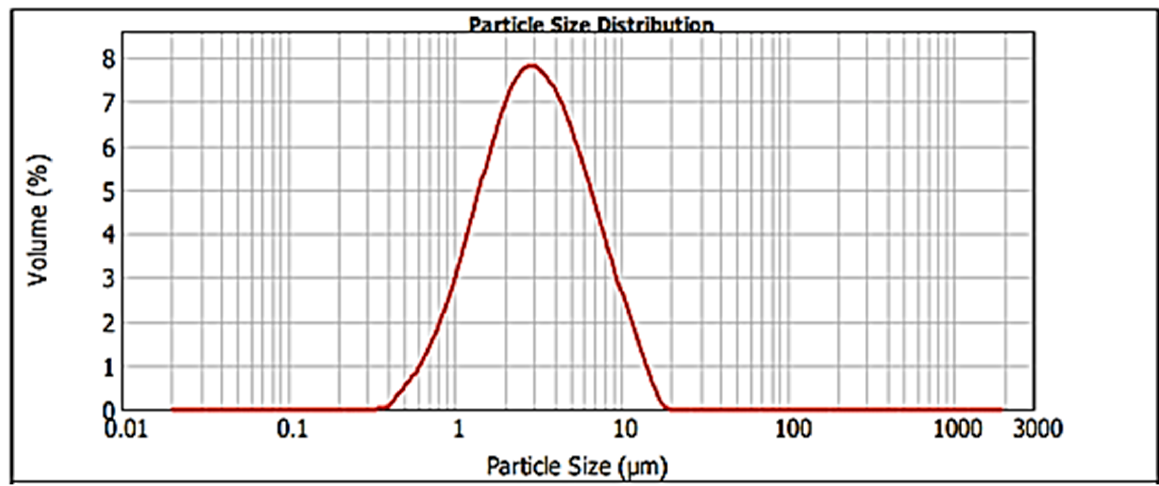
Figure 2. Alumina powder particles size distribution. Table 2. PVD deposition process parameters of the TiN